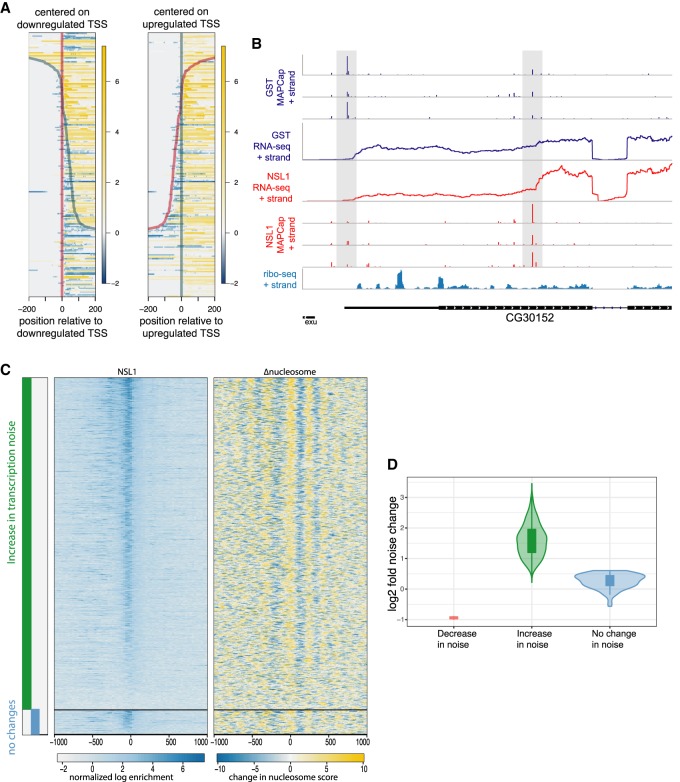
Transcription noise increases in the absence of the NSL complex. (A) Differential signal in RNA-seq comparing control and NSL1 knockdown at 5′ UTR regions. Heat maps are centered at the down-regulated (left) TSS and up-regulated TSS (right) as in Figure 4C. Yellow denotes an increase in RNA-seq read counts, whereas blue denotes a decrease in RNA-seq read counts and thus represent changes in the length of 5′ UTR. (B) Representative example showing MAPCap as well as RNA-seq data for control and NSL1 knockdown samples. Ribo-seq data from wild-type cells are provided (bottom). Ribo-seq data show upstream ORFs in the 5′ UTR region, where expression is reduced in NSL1 knockdown because of a shift in TSS selection. (C) (Leftmost) Bars showing genes with increased (green) and unchanged (blue) transcription variability. Differential variability was calculated using the BASiCS_TestDE function. The BASiCS_TestDE function also corrects for changes in gene expression between control and NSL1 knockdown. (middle and right). Heat maps showing NSL1 binding and changes in nucleosome occupancies upon NSL1 knockdown on the same genes. (D) Violin plot showing the change in transcription variability depicted by the green and blue bars in C.